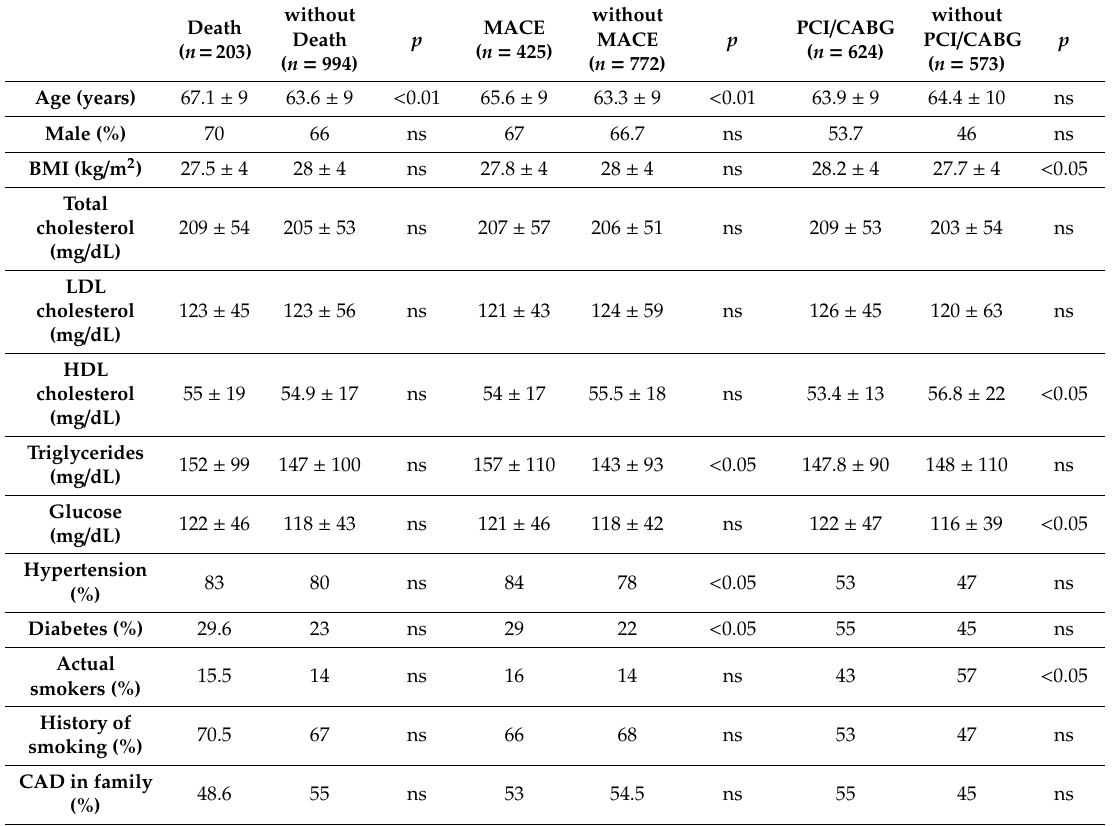
Table 1. Clinical characteristics and prevalence of risk factors of the study groups where the three endpoints (death, MACE, PCI / CABG) occurred and did not